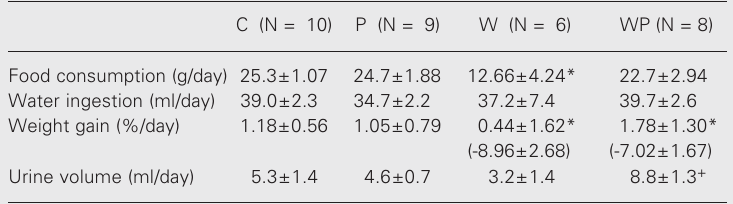
C = control; P = control supplemented with fish oil; W = Walker 256 tumor-bearing rats (W); WP = Walker 256 tumor-bearing rats supplemented with fish oil. Data are reported as mean ± SEM. The values in parentheses represent the percentage of weight gain calculated considering only the carcass weight. *P < 0.05 vs control group. + P < 0.05 vs the other groups (ANOVA, followed by the Student-Newman-Keuls contrast test).